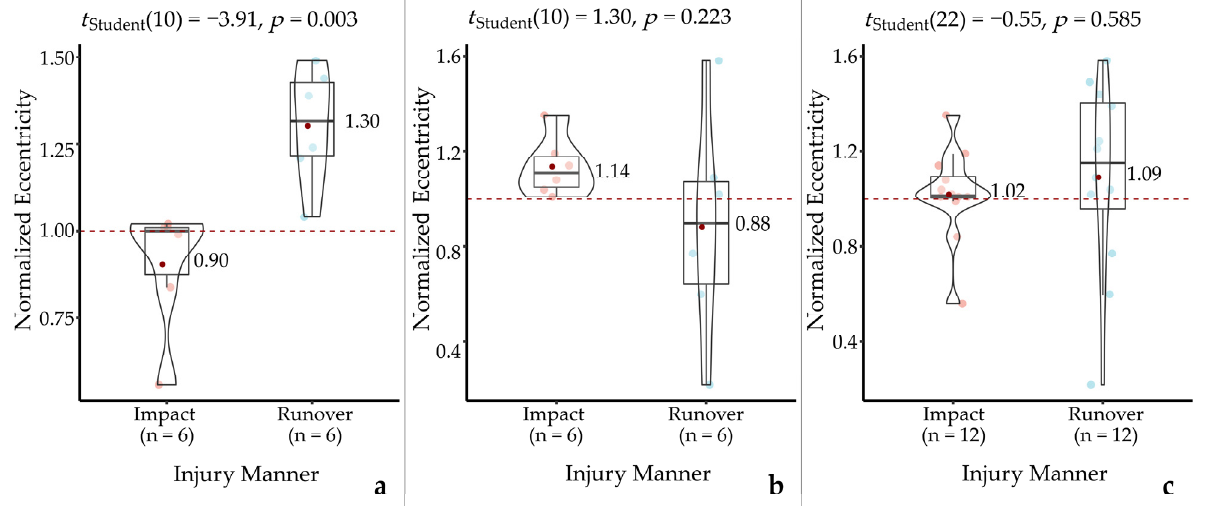
Figure 11. Normalized eccentricities between different injury manners and loading directions. ( a ) Comparison of the normalized eccentricity between different injury manners under the 90° loading direction; ( b ) comparison of the normalized eccentricity between different injury manners under the 270° loading direction; ( c ) comparison of the normalized eccentricity between different injury manners under 90° and 270° loading directions.